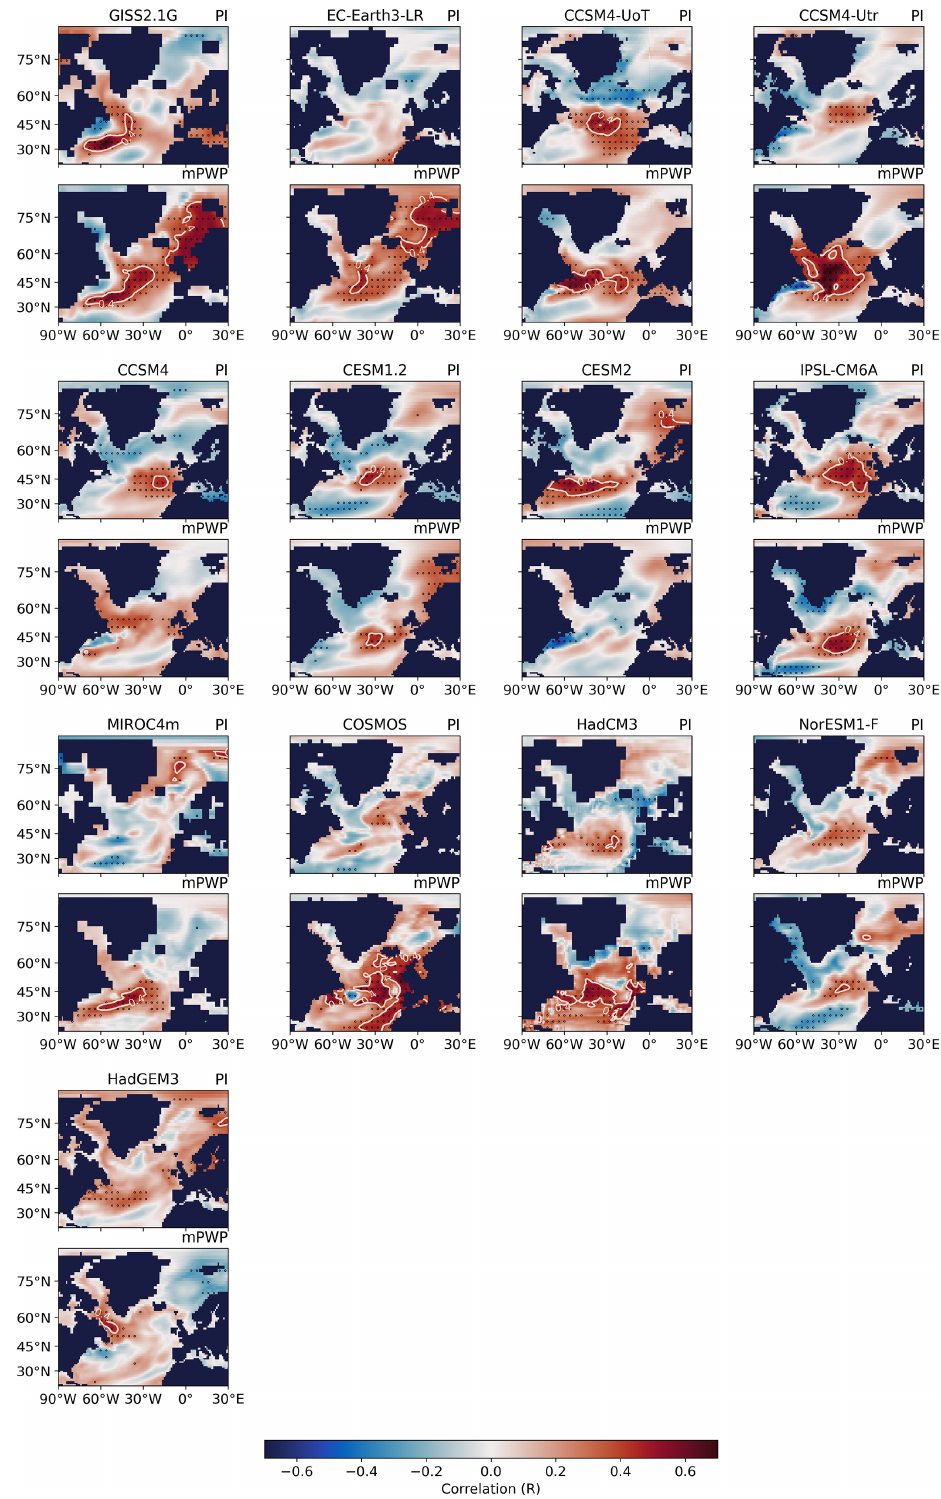
Figure 3. Correlation between the annual AMOC strength and annual SSTs for individual models. The top panel for each model shows the results for the pre-industrial, and the bottom panel shows the results for the mid-Pliocene. Both the AMOC strength and SSTs have been linearly detrended before correlating. Stippling indicates significance at the 95% confidence level. White contours show a positive correlation of R = 0 .